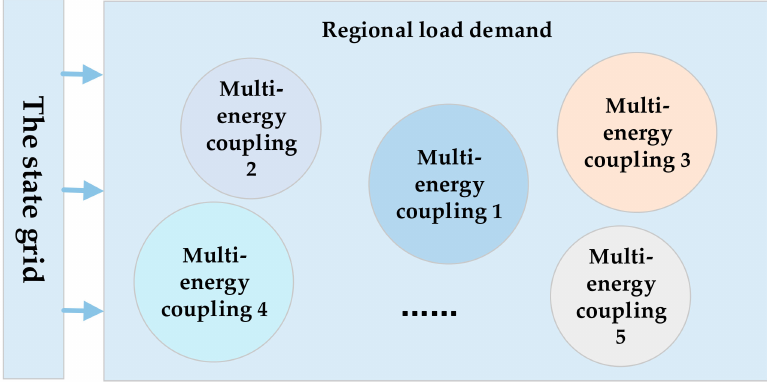
Figure 2. Schematic diagram of power supply and demand structure in the case of multi-energy